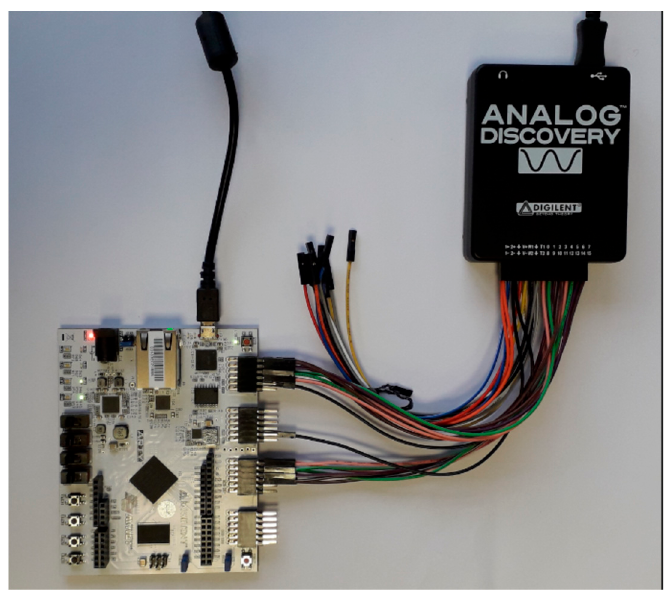
Figure 14. Logic analyzer test set-up using the Digilent ® Analog Discovery.